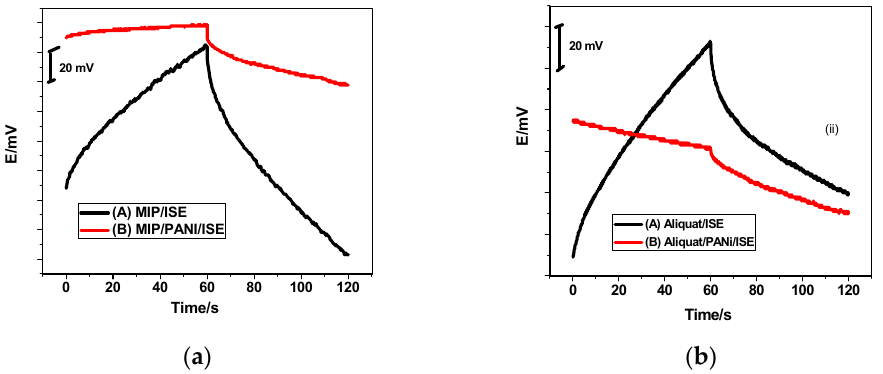
Figure 4. Chronopotentiograms for ( a ) MIP and ( b ) Aliquat based sensors recorded in 10-3M.